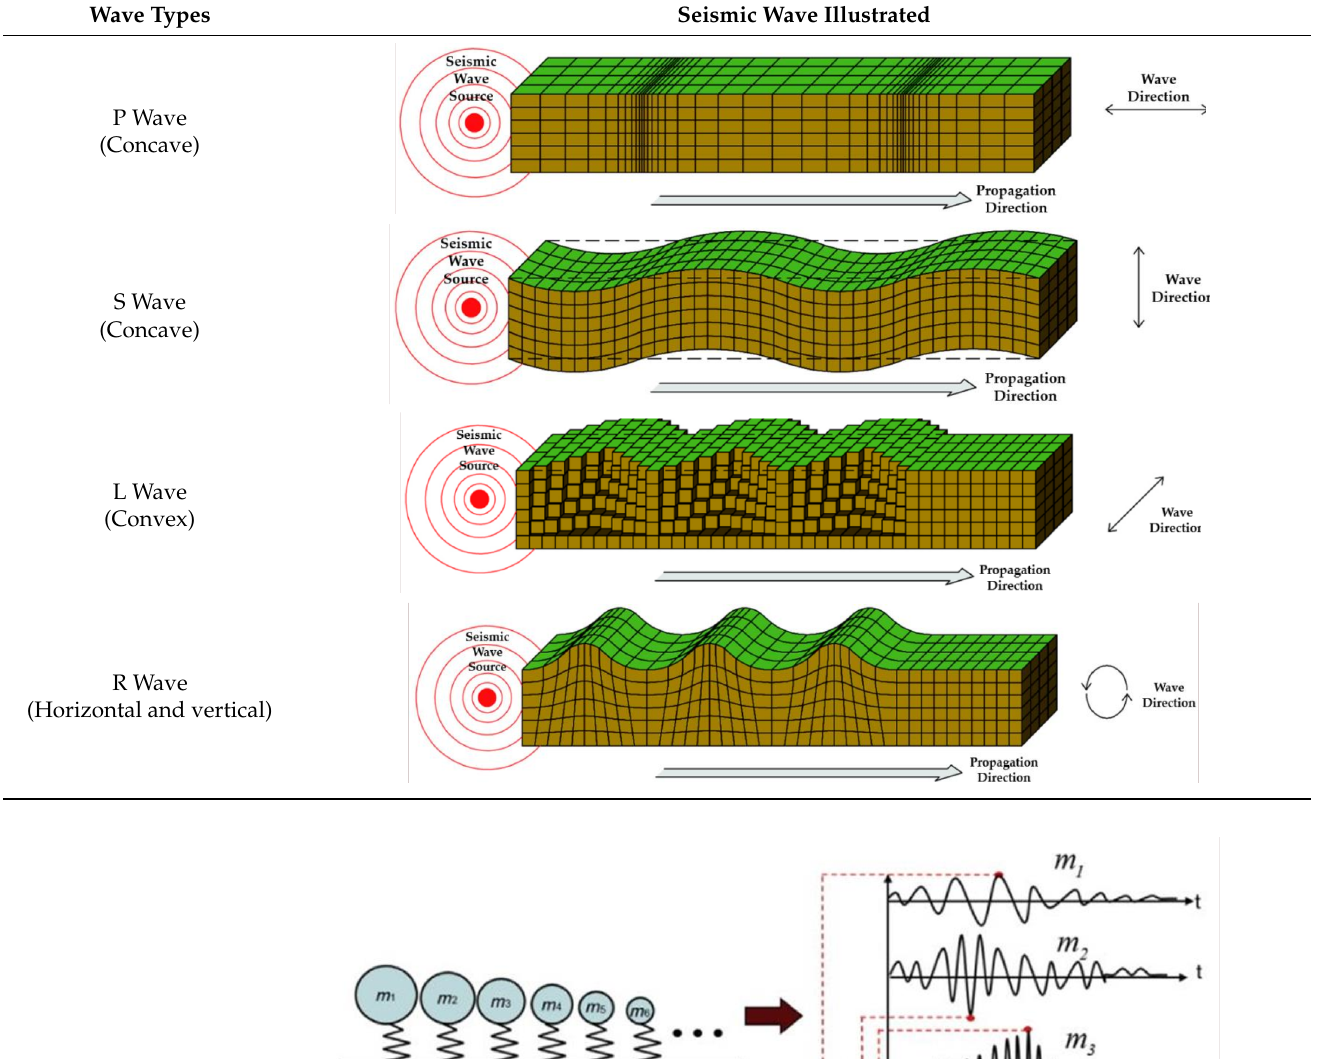
Table 2. Seismic wave types in response to seismic performance design of waterproofing materials [18].